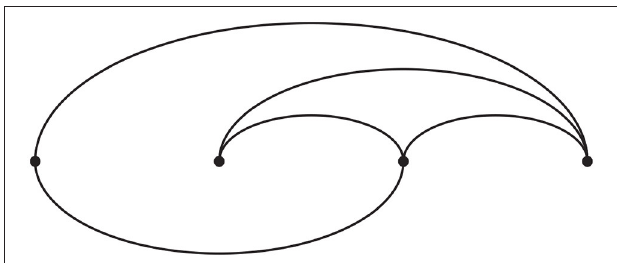
FIGURE 2 | Arc diagram; illustration based on Nicholson (1968).